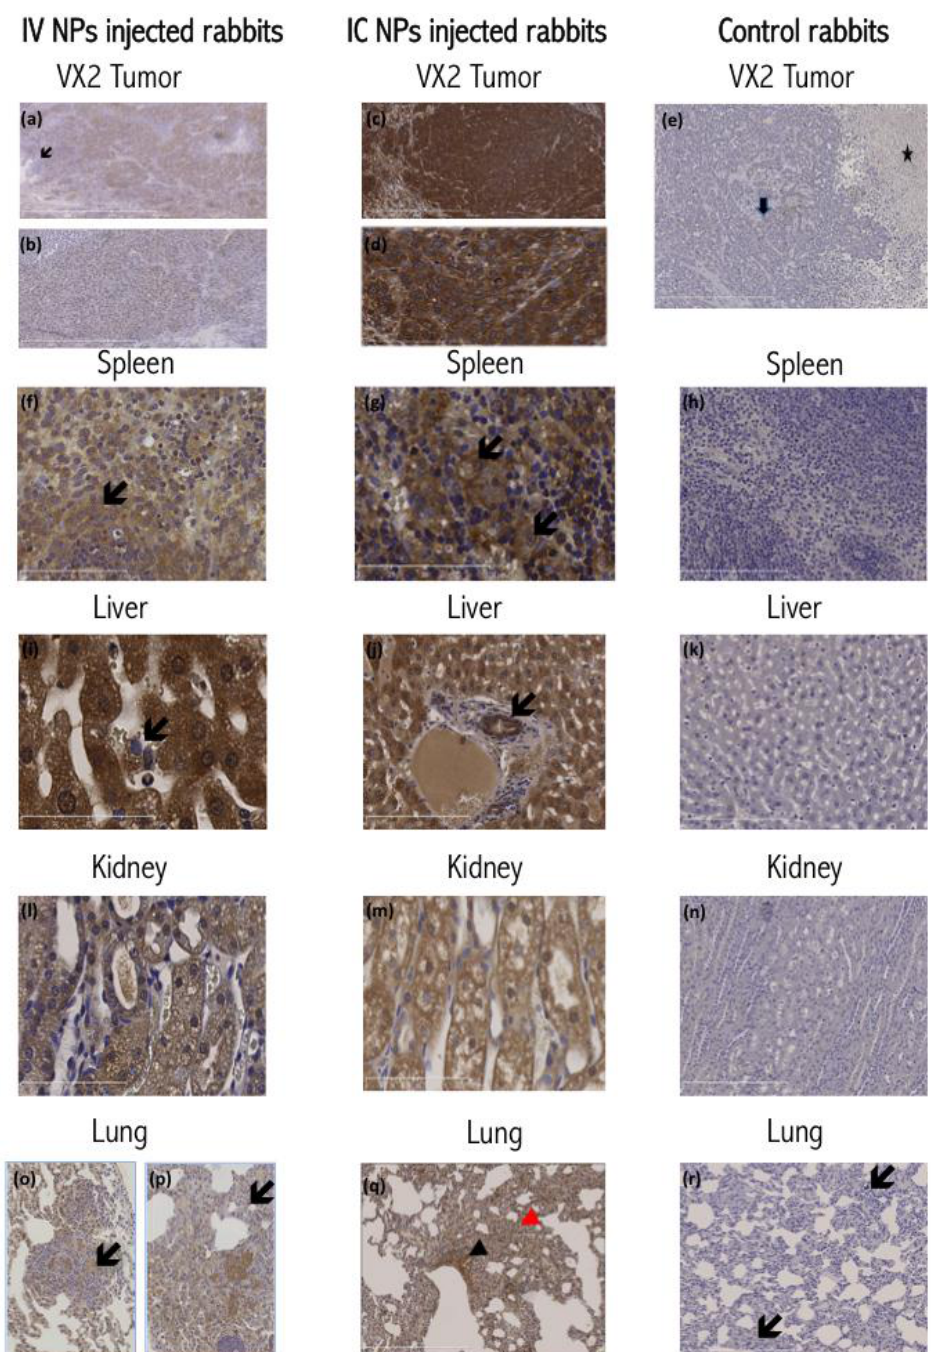
Figure 3. Details from Supplemental Figure S3. Histochemical Staining for NPs: ( a ) IV injected rabbit’s VX2 tumors showing weak uneven staining of tumor masses. Arrow shows weak staining of surrounding hepatocytes (100 ˆ ); ( b ) Photomicrograph showing nuclear staining of IV injected rabbit’s VX2 tumor cells with weak cytoplasmic stain. Surrounding tissues are not stained (200 ˆ ); ( c ) Intense brown nuclear and cytoplasmic staining of the IC injected rabbit’s tumor masses (100 ˆ ); ( d ) Micrograph of IC injected rabbit’s VX2 tumor showing intense positive nuclear and cytoplasmic staining of cells (400 ˆ ); ( e ) Photomicrograph of control rabbit VX2 showing faint non-specific staining of malignant tumor cells (arrow) and necrotic tissues (star); ( f ) Micrograph of IV injected rabbit’s spleen showing positively stained red pulp macrophages and marginal zone macrophages (arrows) (200 ˆ ); ( g ) Micrograph of IC injected rabbit’s spleen showing positively stained red pulp macrophages (400 ˆ ); ( h ) Micrograph of control rabbit’s spleen red pulp showing absence of positive